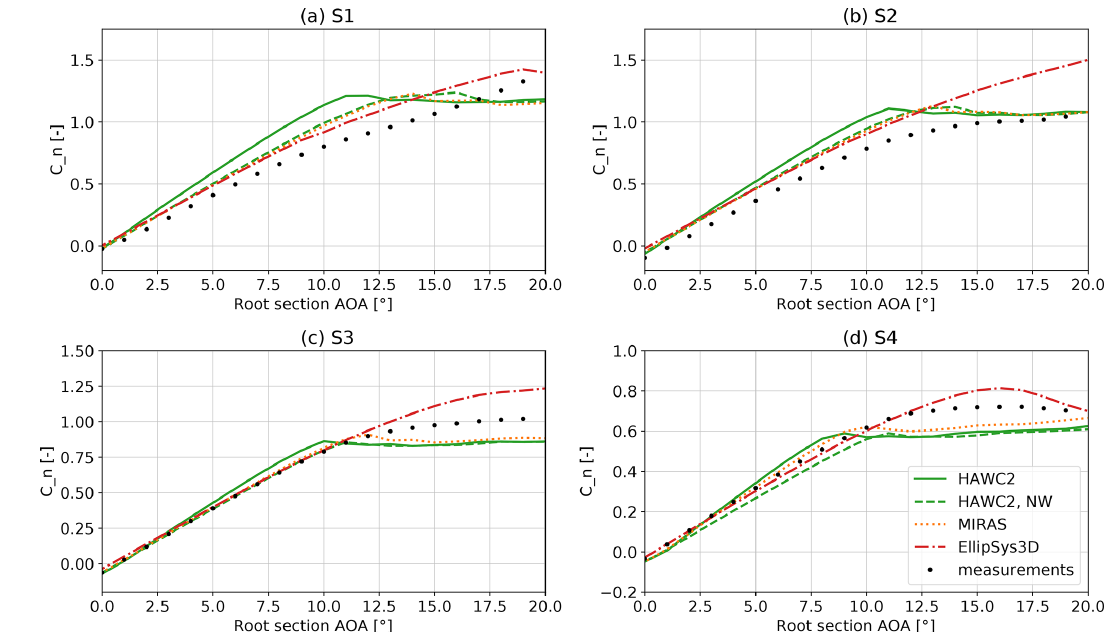
Figure 15. Comparison of measured and simulated c n at the four instrumented sections for tripped